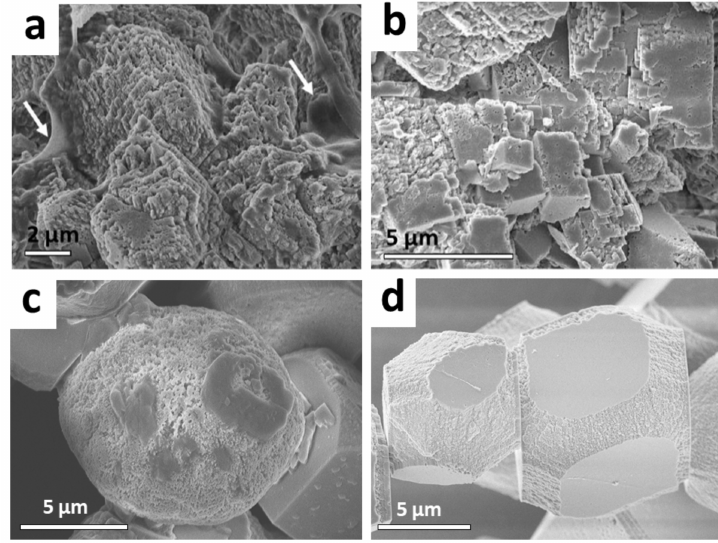
Figure 5. ( a , b ) SEM images of calcite particles found in the travertine specimens (after [44]). ( a ) Calcite aggregate composed of a dense arrangement of calcite nanoparticles. The arrows mark the extracellular polymeric substance (EPS). ( b ) Low magnification image showing calcite particles with a relatively smooth surface. ( c , d ) SEM images of calcite crystals from samples prepared in the gum arabic containing system with growth times of 2 h. ( c , d ) Reproduced from [45] with permission from The Royal Society of